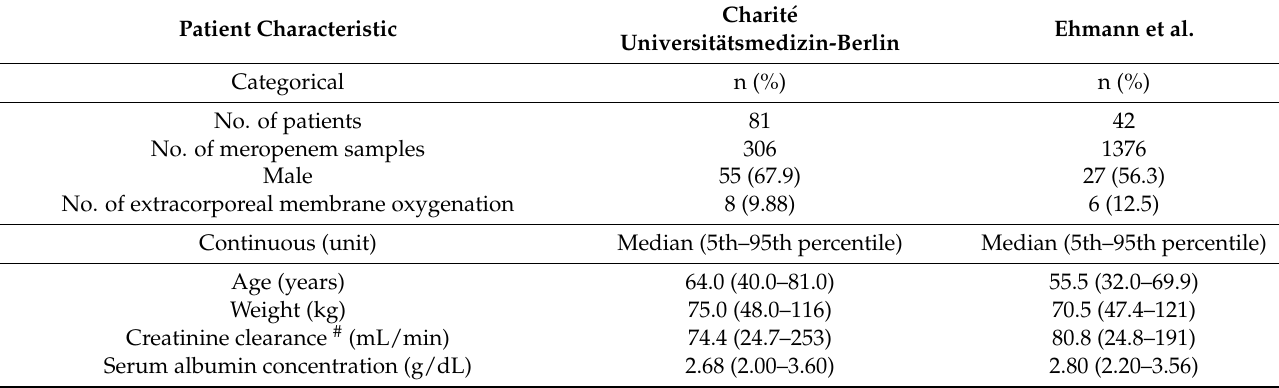
Table 2. Overview of patient